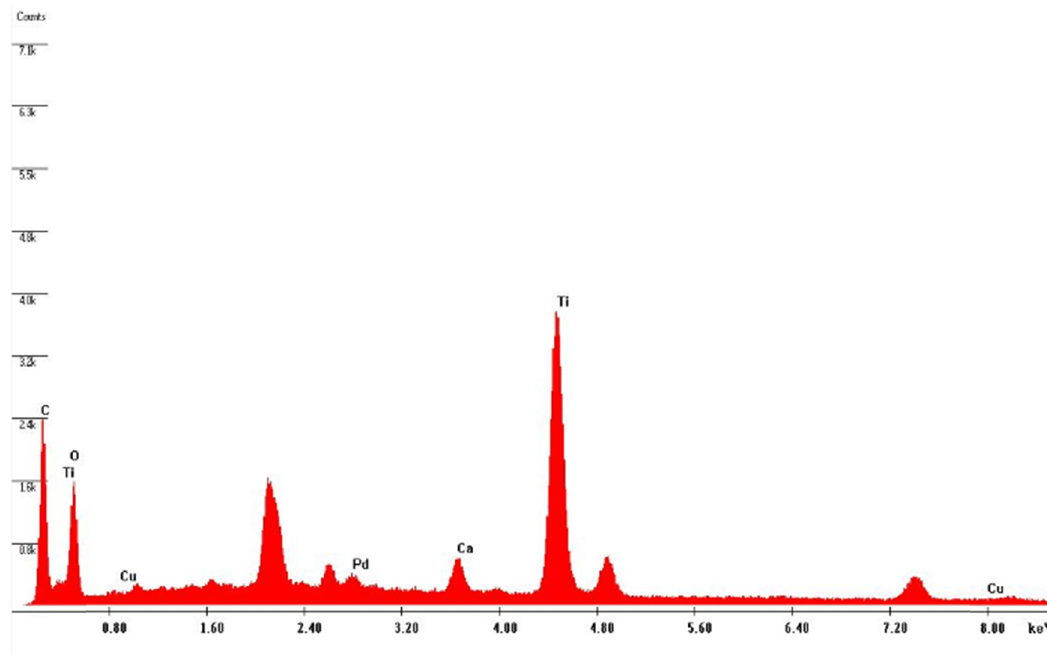
Figure 13: Nitrate conversion ( % ) analyzed by UV - Vis after 3 h of catalytic reduction using the supported catalysts: 4Pd – 1Cu/FCNT1, 4Pd – 1Cu/FCNT2, 4Pd – 1Cu/AC, 4Pd – 1Cu/SBA - 15, and 4Pd – 1Cu/TiO 2 prepared by method 1 ( C NO